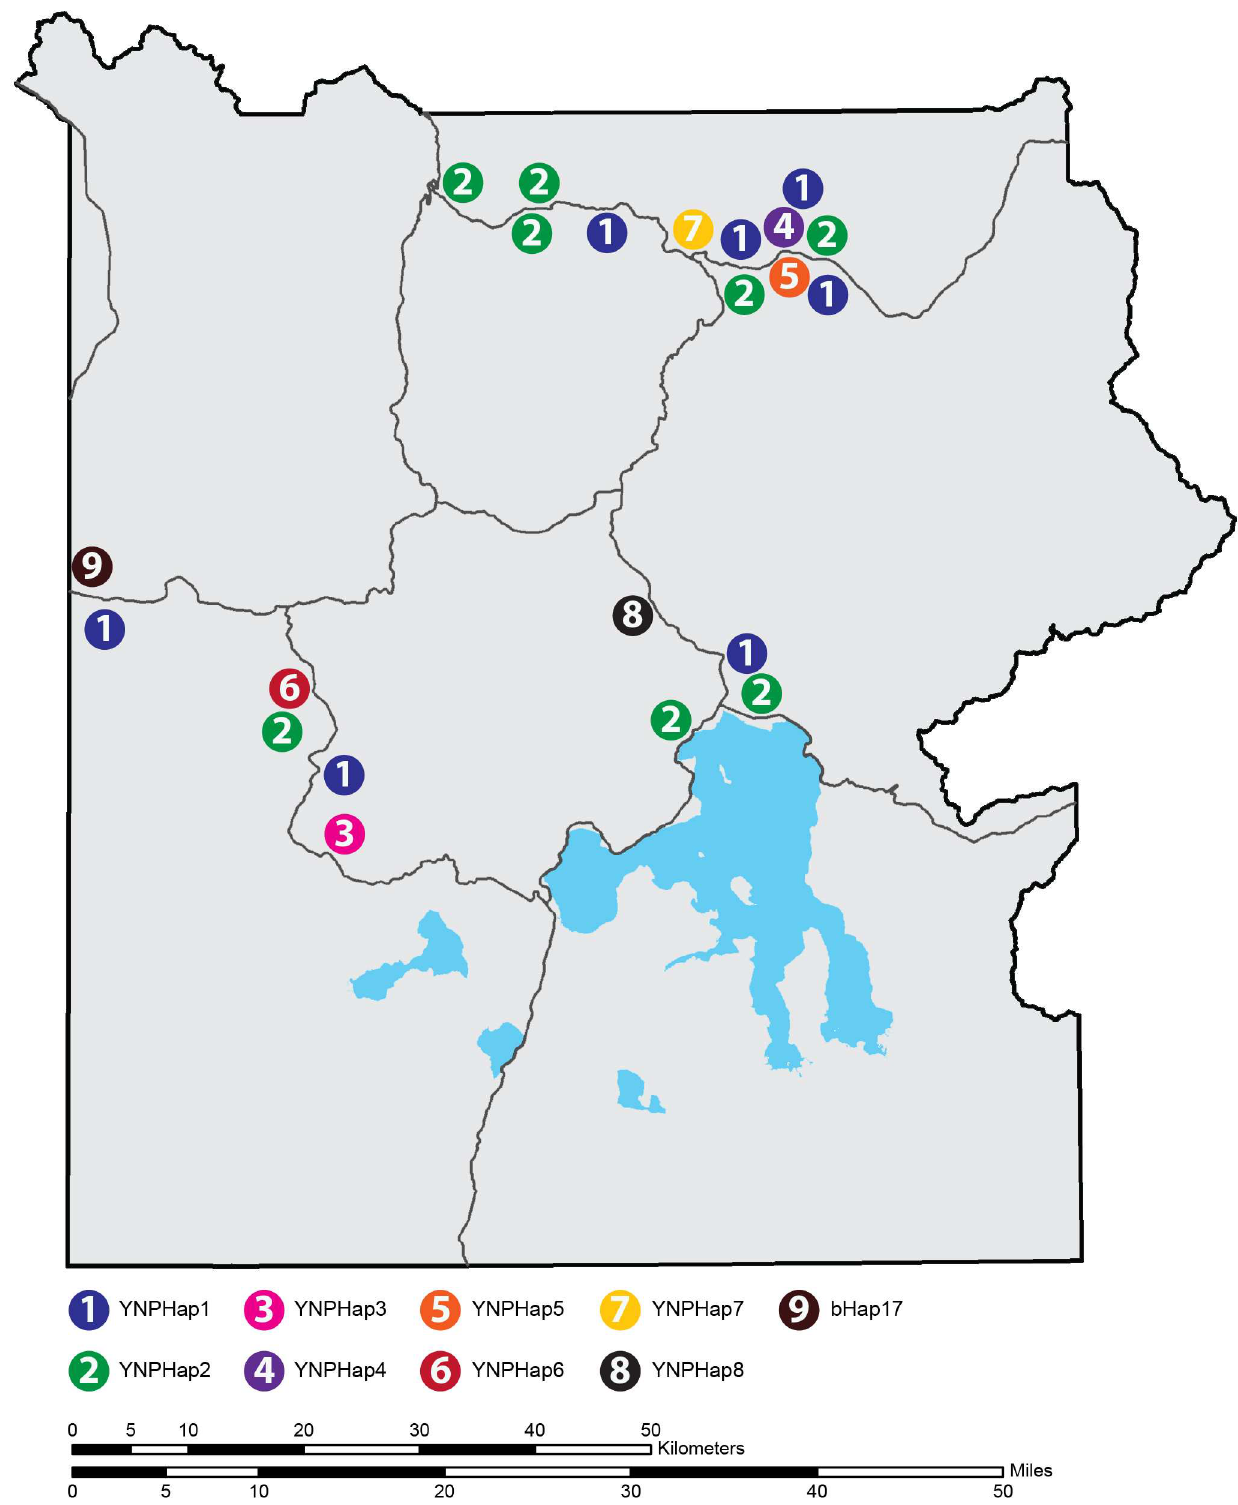
Fig 1. Mitochondrial haplotype distribution in Yellowstone National Park. The samplinglocationand haplotypeidentity of each Yellowstone bison in this study based on their association with either the northern or central herds. Three additionalsamples(Templeton,and two YNPHap2bison) were collectedfrom bison near the north boundary at a capture facility, but their movement historiesare unknown,and they were omitted from this figure. doi:10.1371/journal.pone.0166081.g001 PLOS ONE | DOI:10.1371/journal.pone.0166081 November23,